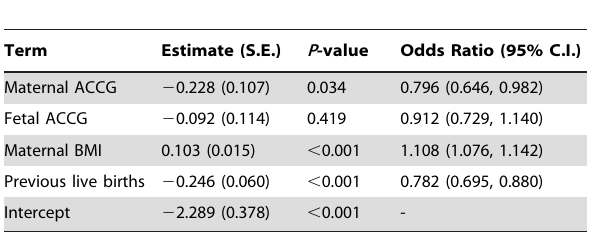
Table 3. Logistic regression model of primary risk factors for preeclampsia including presence of the ACCG COMT haplotype.